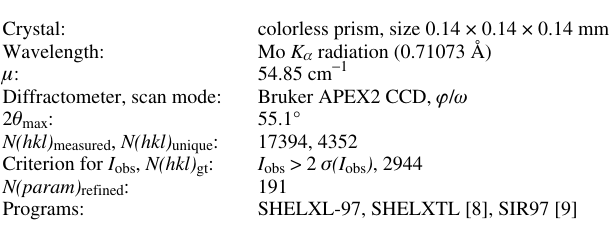
Table 1. Data collection and handling.